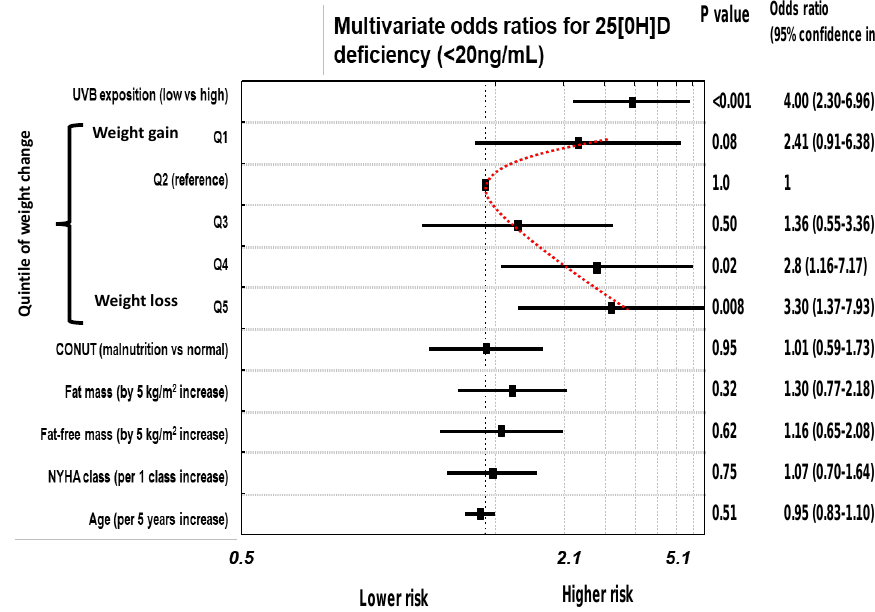
Figure 4. The risk of 25[OH]D deficiency in patients with di ff erent levels of weight change (WC). Independent predictors in multivariable